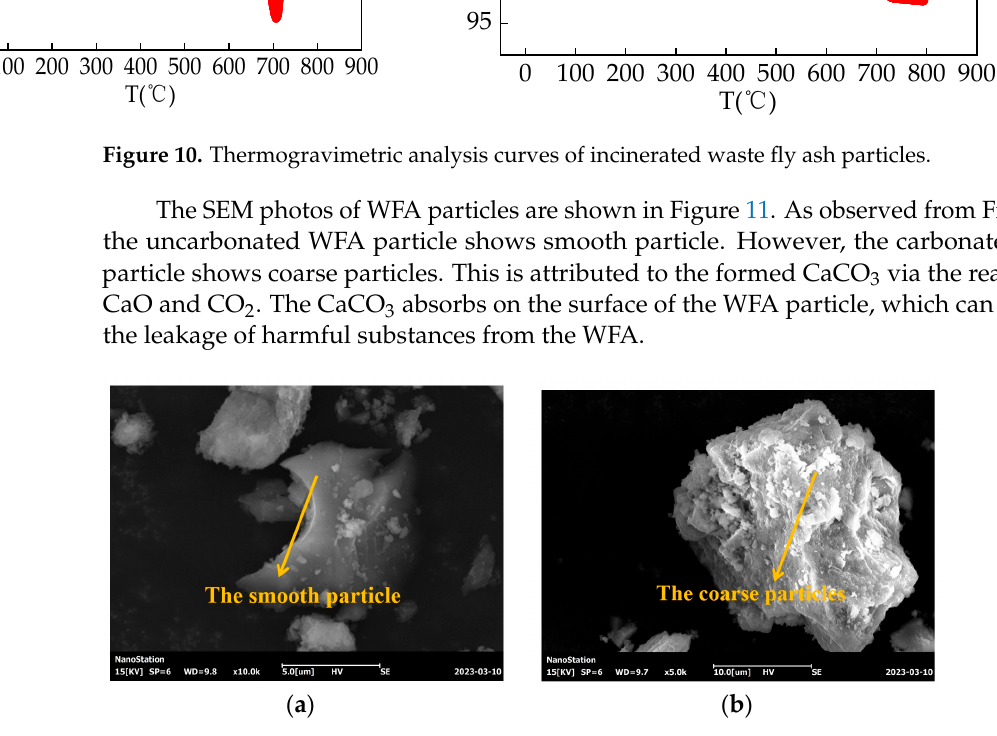
Figure 11. The SEM photos of incinerated waste fly ash particles. ( a ) The incinerated waste fly ash particle ( b ) The carbonated incinerated waste fly ash particle.